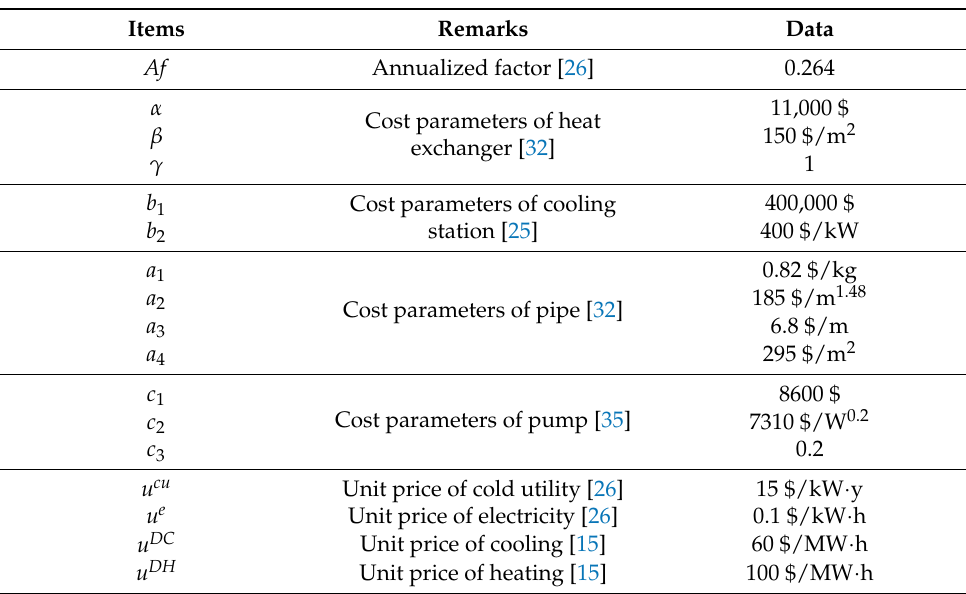
Table 5. Economic parameters of the